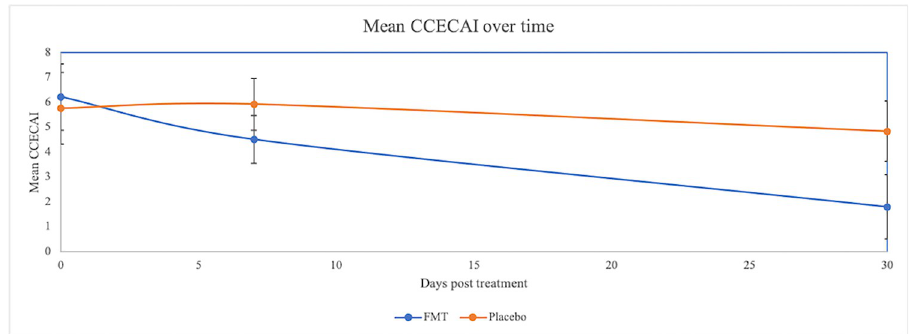
Fig 1. Mean CCECAI over time between the placebo and FMT group. No significant differences were noted between groups at each time point, although time remained a significant factor, with the lowest scores achieved by day 30 (p = 0.01).